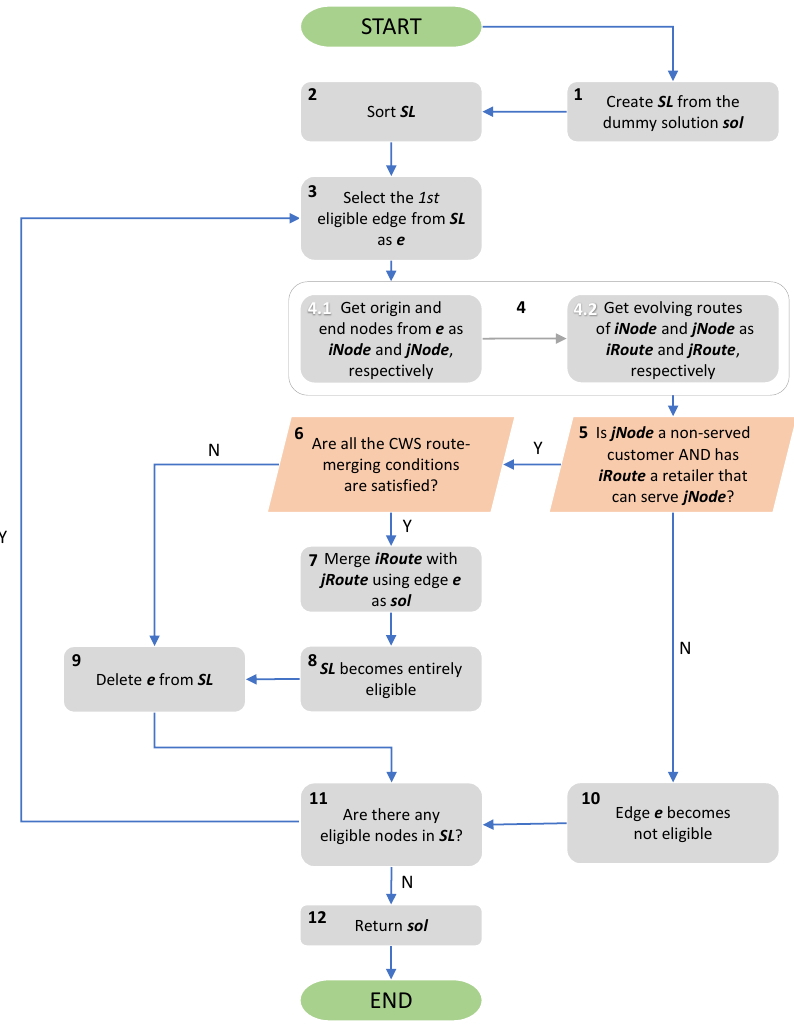
Figure 3. The flowchart of CWS 1